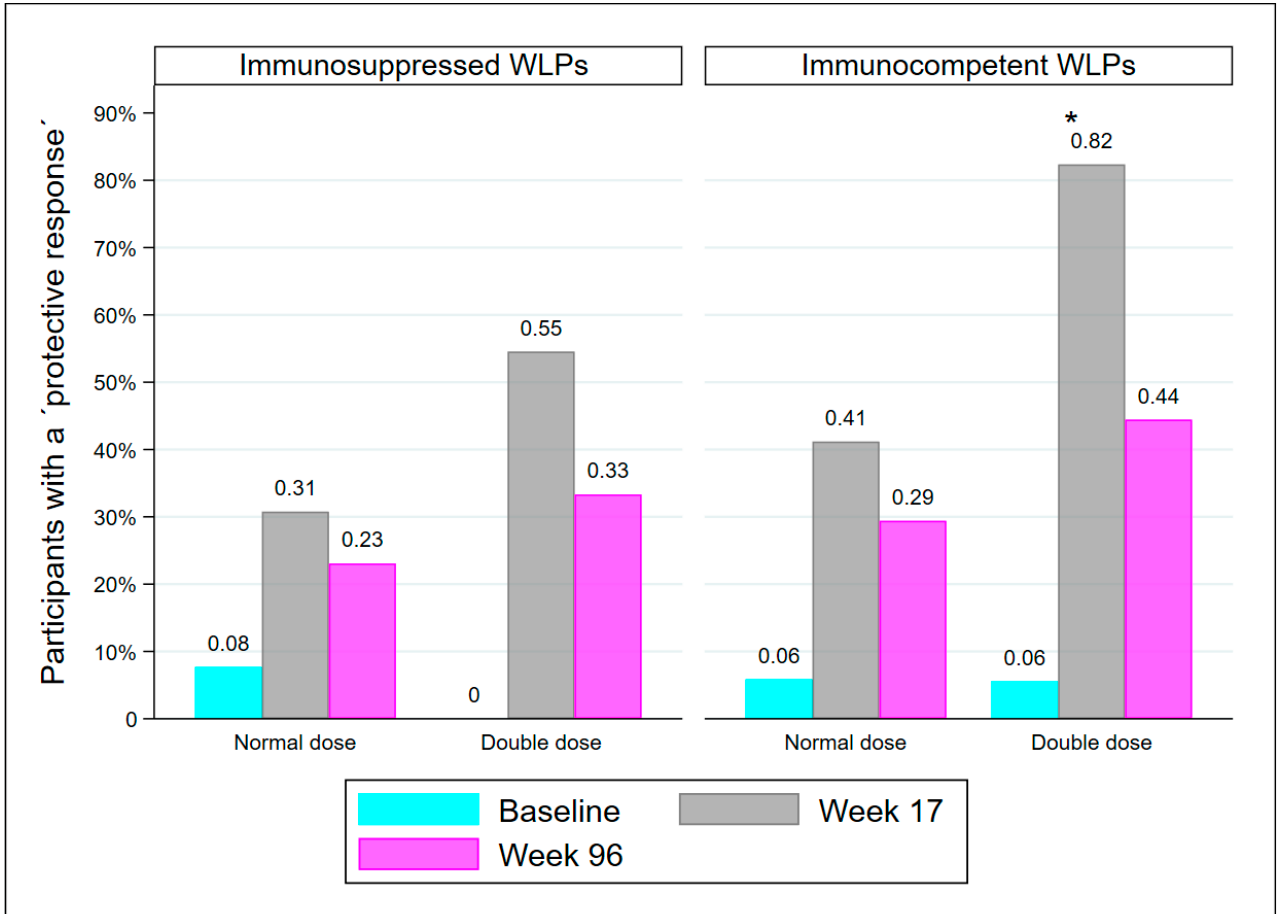
Figure 4. Immunocompetent WLPs and medical immunosuppressed WLPs who are protected at baseline, week 17, and week 96, divided into dose groups. Abbreviations: WLP, patients on the kidney transplant waiting list, *: p < 0.05, compared to immunocompetent WLP-ND at week 17.